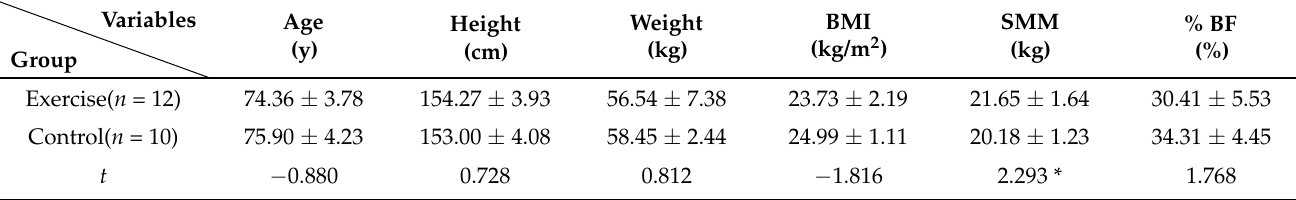
Table 1. Physical characteristics of participants in each group.